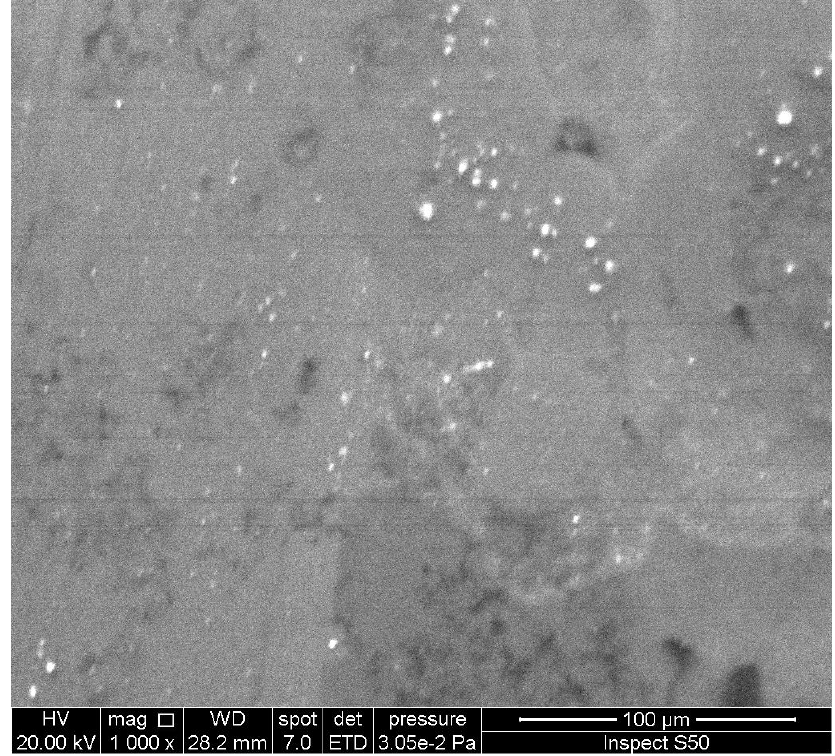
Figure 12. SEM image of the surface of an irradiated PVC film in the absence of any additive.